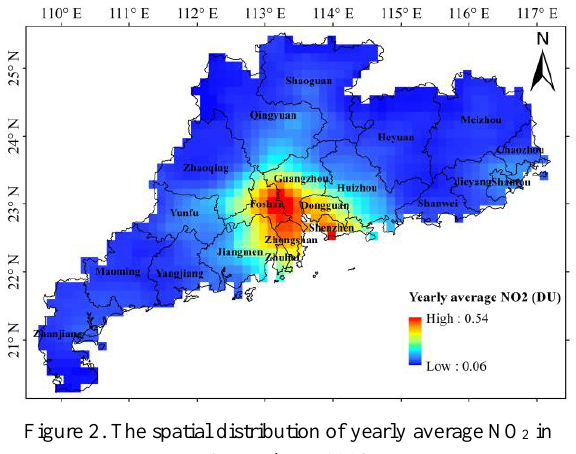
Figure 1. The spatial distribution of yearly average PM 2.5 in Guangdong, 2016 The spatial distribution of annual average NO 2 column concentration over the Guangdong province in 2016 is shown in Figure 2, which is quite different from the spatial characteristics of PM 2.5 . The highest values of NO 2 mainly occur over the middle Pearl River Delta (PRD) region, including Guangzhou, Dongguan, Foshan, Zhenshen and Zhongshan. Cities along the boundary of PRD showed relatively higher NO 2 concentrations, whereas cities outside PRD had low NO 2 values.